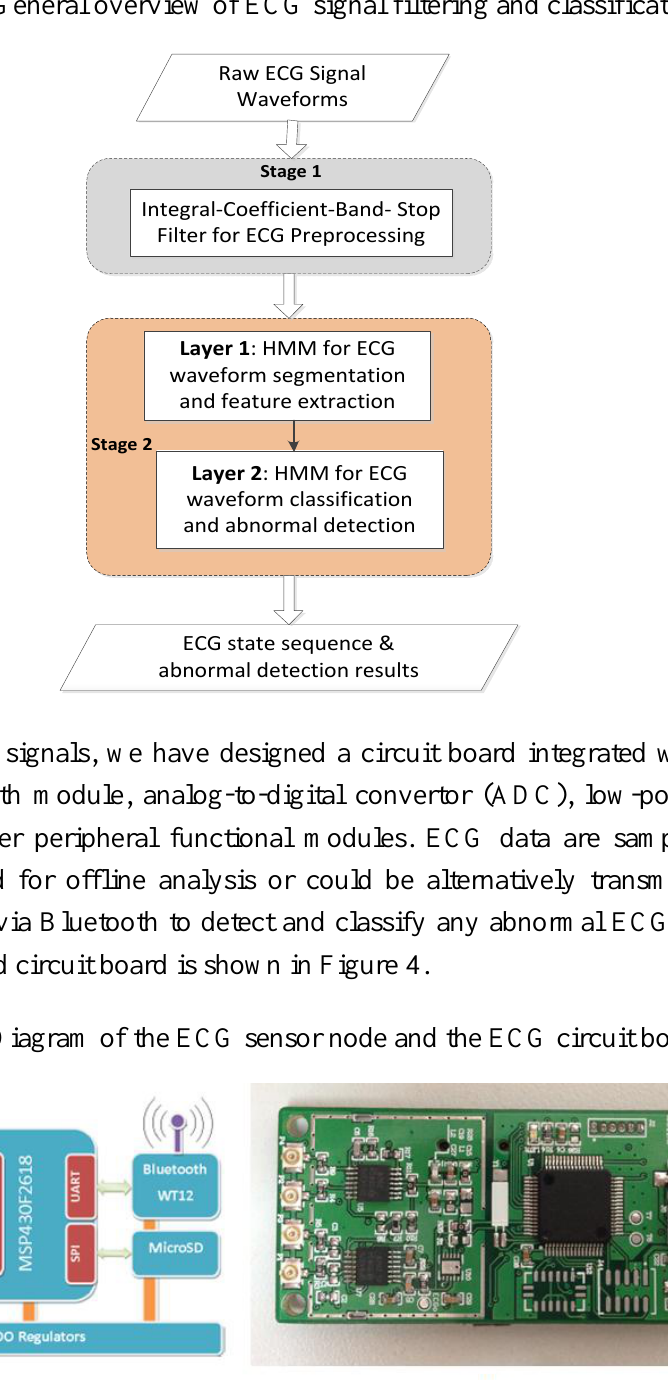
Figure 3. General overview of ECG signal filtering and classification.